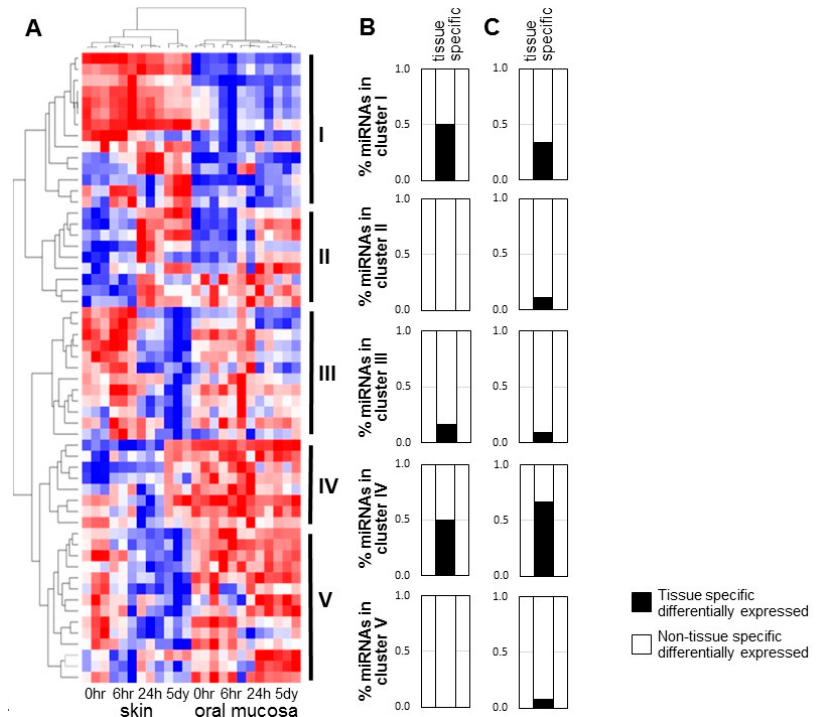
Figure 1. Di ff erentially expressed high expresser microRNAs during wound-healing of skin and oral mucosal epithelium. An existing miR-Seq dataset of paired skin and oral mucosal wound-healing over time (0 h, 6 h, 24 h, 5 day) was reanalyzed and a cuto ff value of 5458 (average number of mapped sequence reads of the whole dataset) was applied. A panel of 57 di ff erentially expressed ( p < 0.01) highly expressed microRNAs were identified, which were grouped into 5 clusters based on hierarchical clustering ( A ). The tissue specificity of these clusters was further assessed by comparing the members of each clusters with a previously reported panel of tissue-specific di ff erentially expressed microRNAs [10]. The percentage of microRNAs that were identified as tissue specific in each cluster is presented ( B ). An independent microRNA profiling analysis of unwounded skin and oral mucosal epithelium (base line, n = 3, pooled samples), performed using a mouse microRNA microarray, allowed the identification of 85 tissue-specific microRNAs (Supplementary Figure S4 and Supplementary Table S2). The percentage of microRNAs in each of the 5 clusters that were identified as tissue specific based on this new list is shown ( C